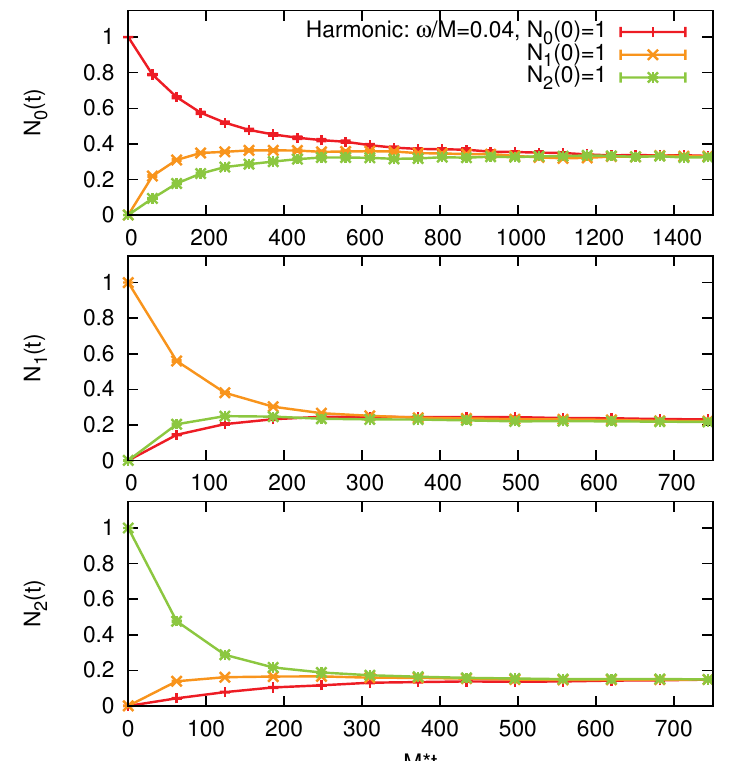
Figure 3 . Time evolution of the occupation number of the eigenstates in the harmonic potential with ! = 0 : 04 M . The bars denote statistical